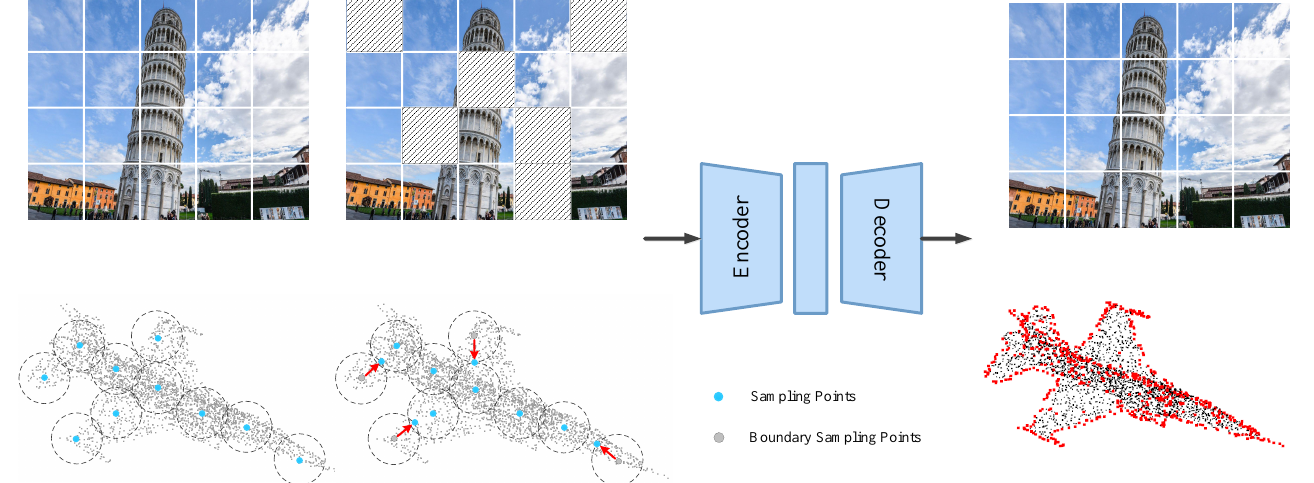
Figure 3. Illustration of the mixed feature prediction task. We compare our mixed feature prediction task with the masked autoencoding workflow in the 2D image domain. The upper row shows the process to train an autoencoder by reconstructing the masked patches from the unmasked parts of the input image data. The lower row describes the main idea of an analogous method applicable to point clouds. An encoder is trained to learn sharp features of point clouds with mixed boundary feature